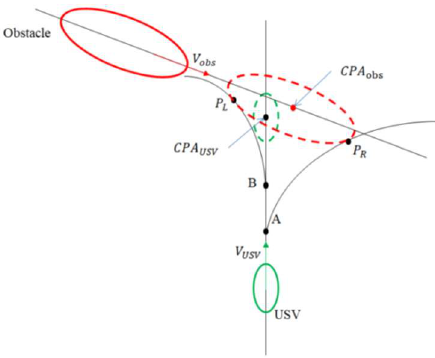
Figure 8. Close point approach and start avoidance